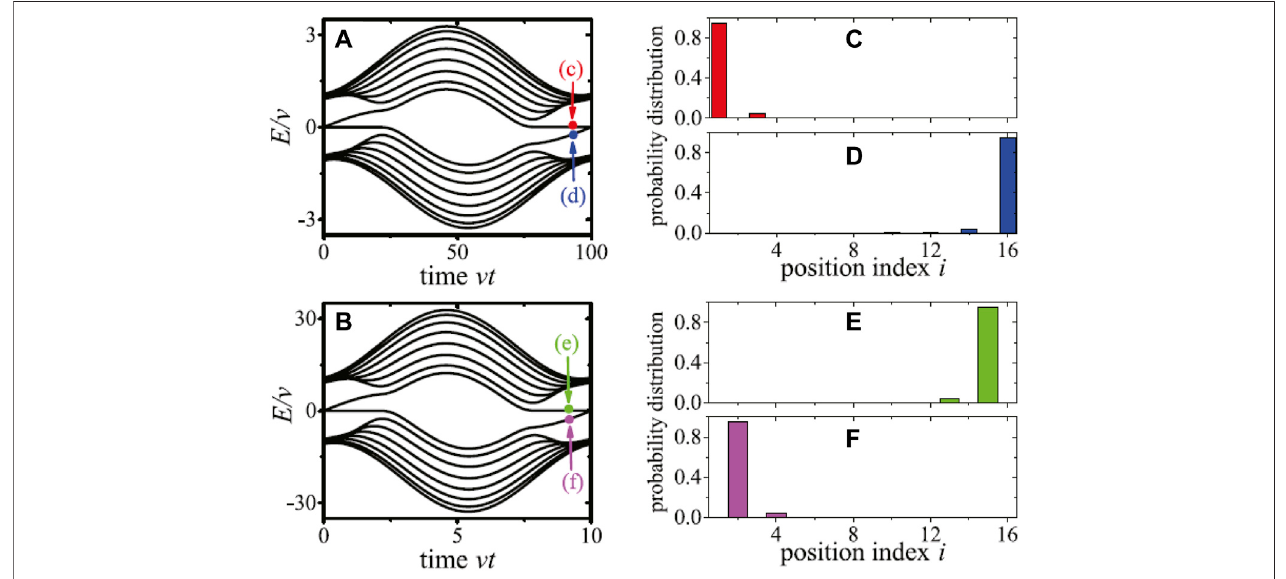
FIGURE8| (Coloronline)Instantaneousspectrumoftheopenchainoptomechanicalarrayfor N (cid:1) 8.Thetimedependentpumpsequenceisde fi nedin Eq.29 ,with (A) z / v (cid:1) 0.1, A / v (cid:1) 1.1,and ω / v (cid:1) 2 π /100; (B) z / v (cid:1) 10, A / v (cid:1) 11,and ω / v (cid:1) 2 π /10. (C – F) showtheprobabilitydistributionsoftheedgestatescorrespondingtothepoints shown in (A, B) . The phase factor is ϕ (cid:1) 0.